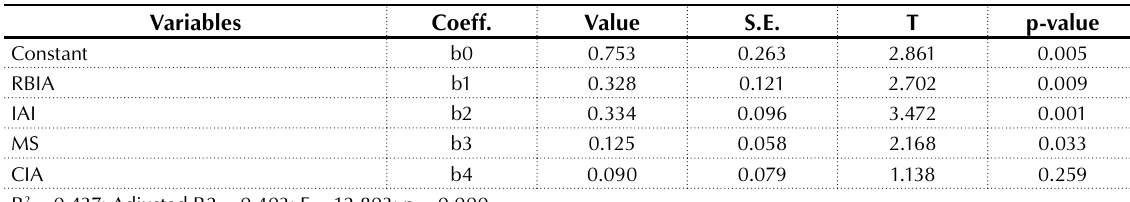
Table 4. Regression